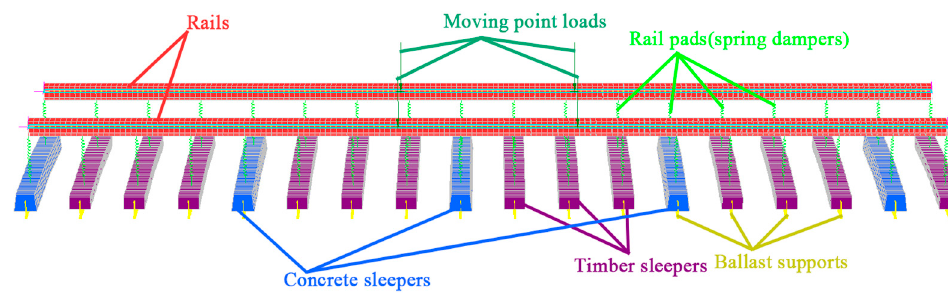
Figure 5. 1:4 interspersed track FEM model.